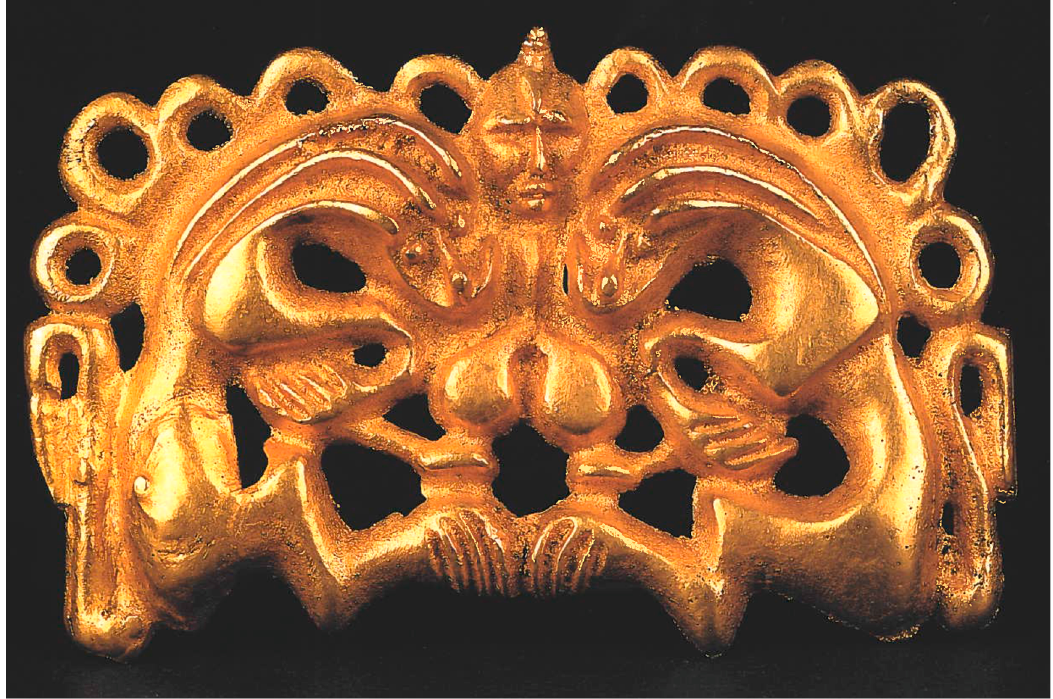
Figure 11. Human–animal juxtaposition plaque, gold, 10 × 5.8 cm, excavated from Beihalatu, Horqin Left Middle Banner, Inner Mongolia. From third to fourth century; after (Shanghai Bowuguan 2000, p. 143).